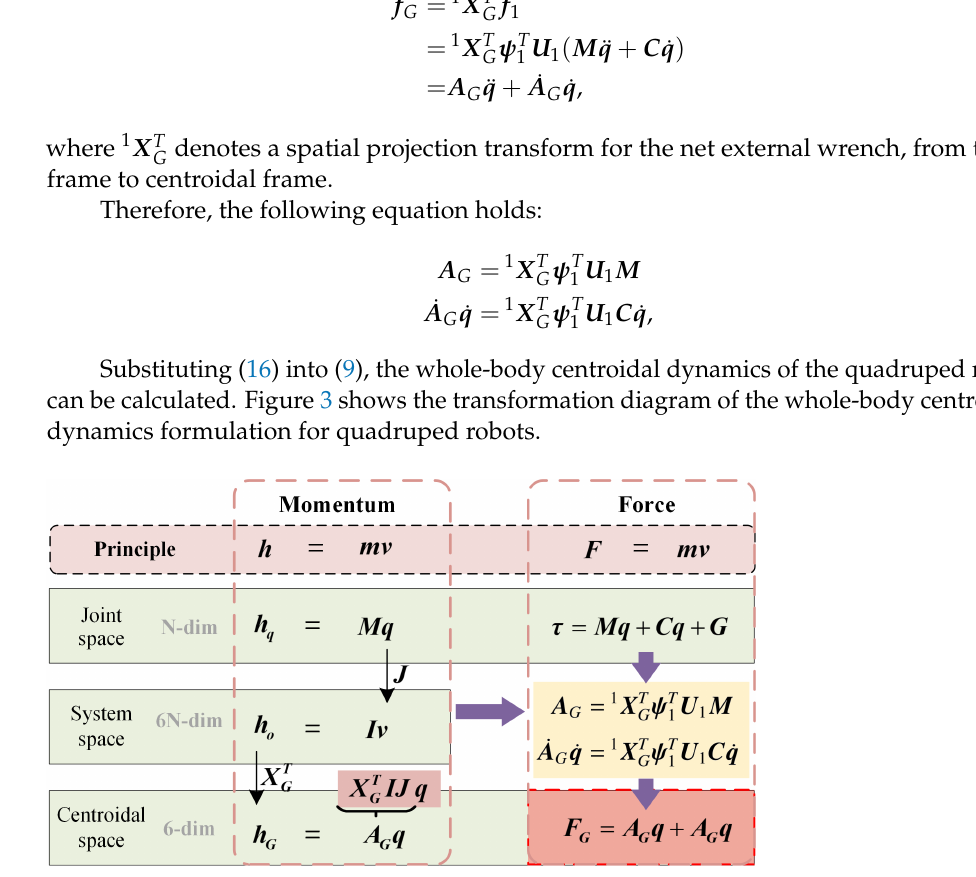
Figure 3. Transformation diagram of the whole-body centroidal dynamics formulation for quadruped